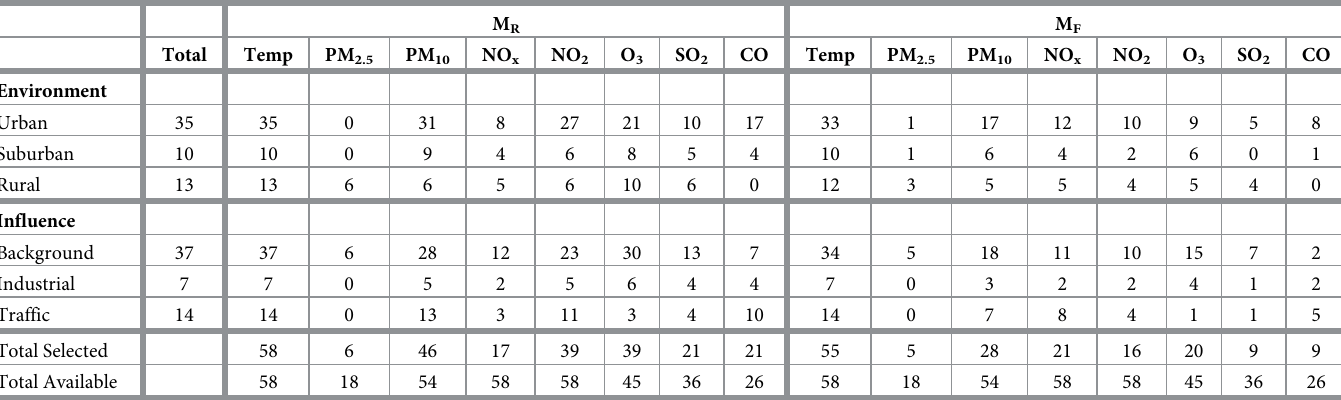
Table 1. Number of selected covariates in the M R and M F models stratified by type of environment and type of influence. M